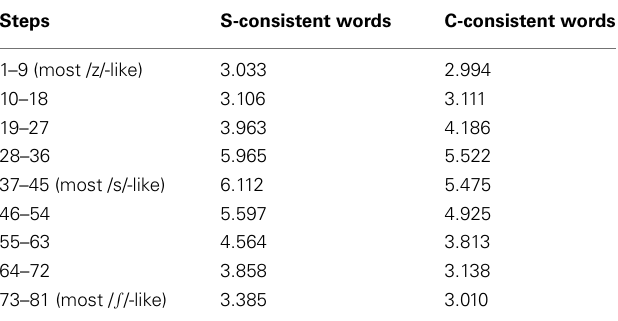
Table 2 | Experiment 1: mean ratings byAustralian listeners for S- versus C-consistent words across nine 9-step portions of the 81-step continuum from /z/ through /s/ to / ∫ /.